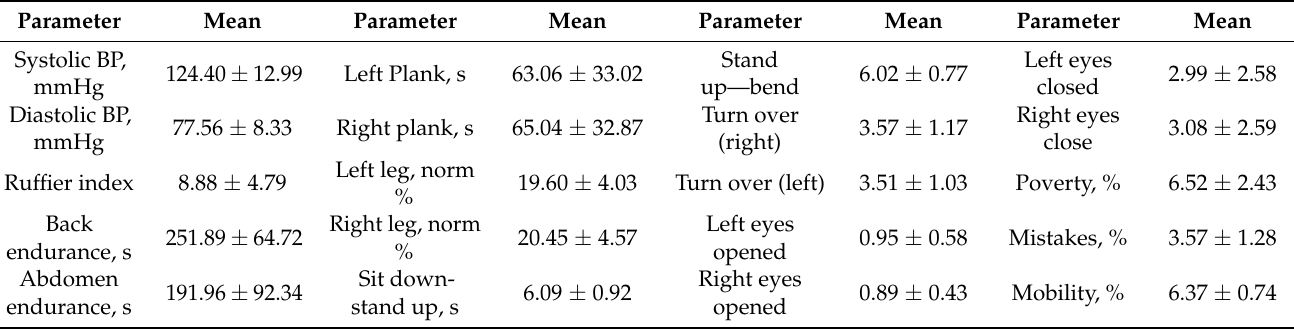
Table 1. Basic statistics of each feature in health evaluation system